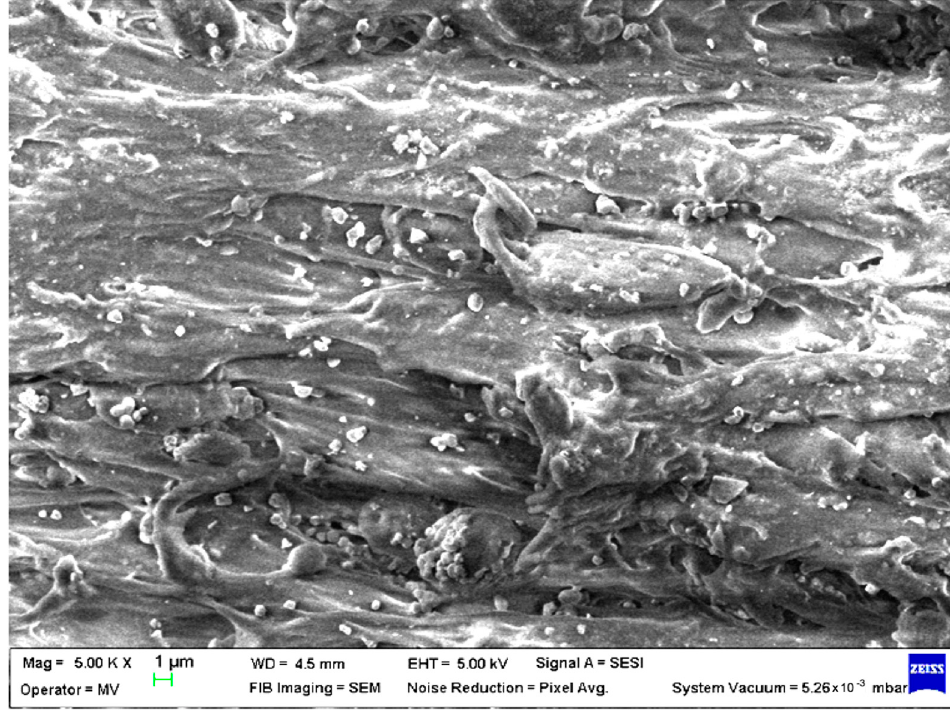
Figure 5. SEM micrographs of PET–Fe composite (M5) sample at T 0 (1 μ m scale). The SEM micrograph of a PET–PP composite pellet (sample M6) revealed a highly open structure with multiple irregularities due to the PP fibres (Figure 6).